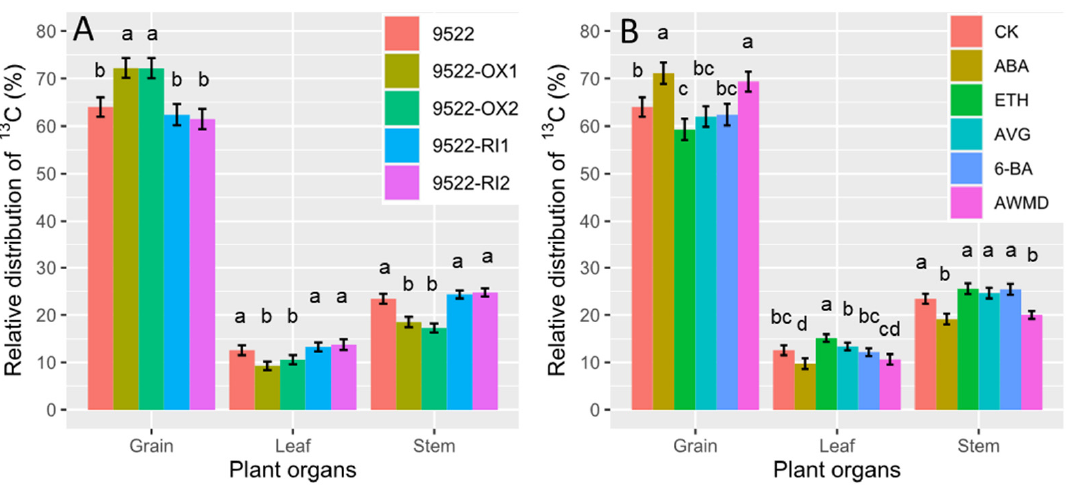
Figure 6. Relative partitioning 13 C in the grains, leaves, and stems of wildtype and transgenic lines ( A ), and application of exogenous phytohormone/alternate wetting and under moderate drying (AWMD) irrigation ( B ) at harvest stage. Symbols and significance levels are as described in Figure 1. The total sugars as nonstructural carbohydrates (NSCs, including soluble sugars + starch) in stems decreased during grain filling (Figure 7). The decrease in NSC was faster in 9522-OX lines than in 9522-RI lines and wildtype plants. NSC contents sharply decreased from 8 to 28 days after anthesis, and overexpression of OsNYC3 accelerated this process. The changes in NSC concentration varied across different treatments, with ABA and AWMD causing the sharpest decreases in NSC of the stems, but 6-BA and ETH impeded the progress of reallocation of pre-anthesis assimilates from the stems to grains. These results were consistent with the 13 CO 2 labeling data (Figure 6).